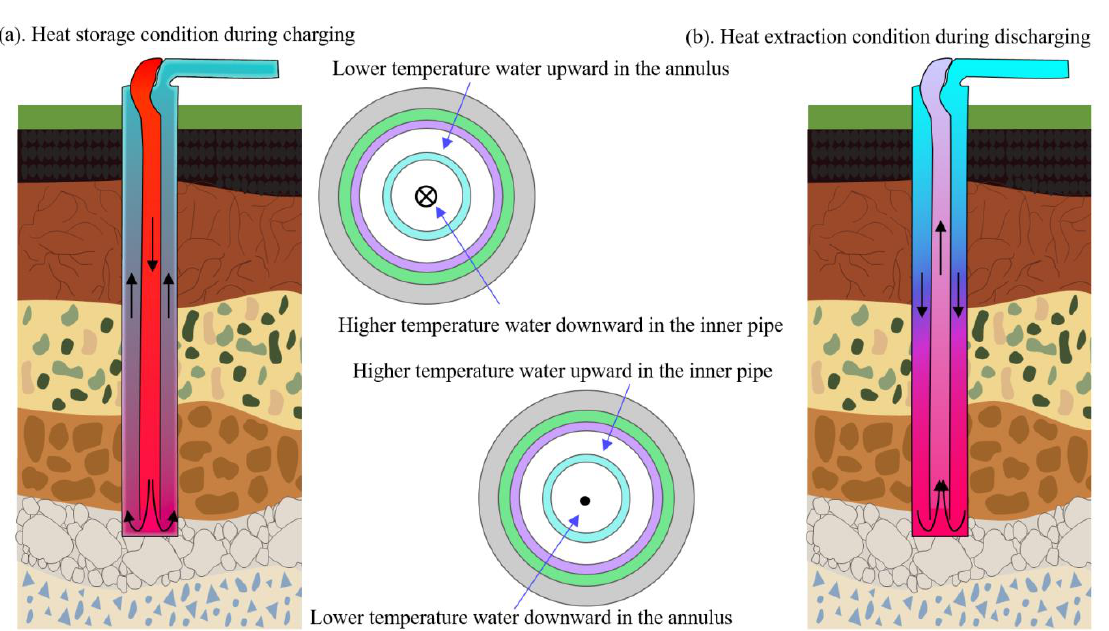
Figure 4. Two typical operating conditions for heat storage and heat extraction of the deep BTES system.